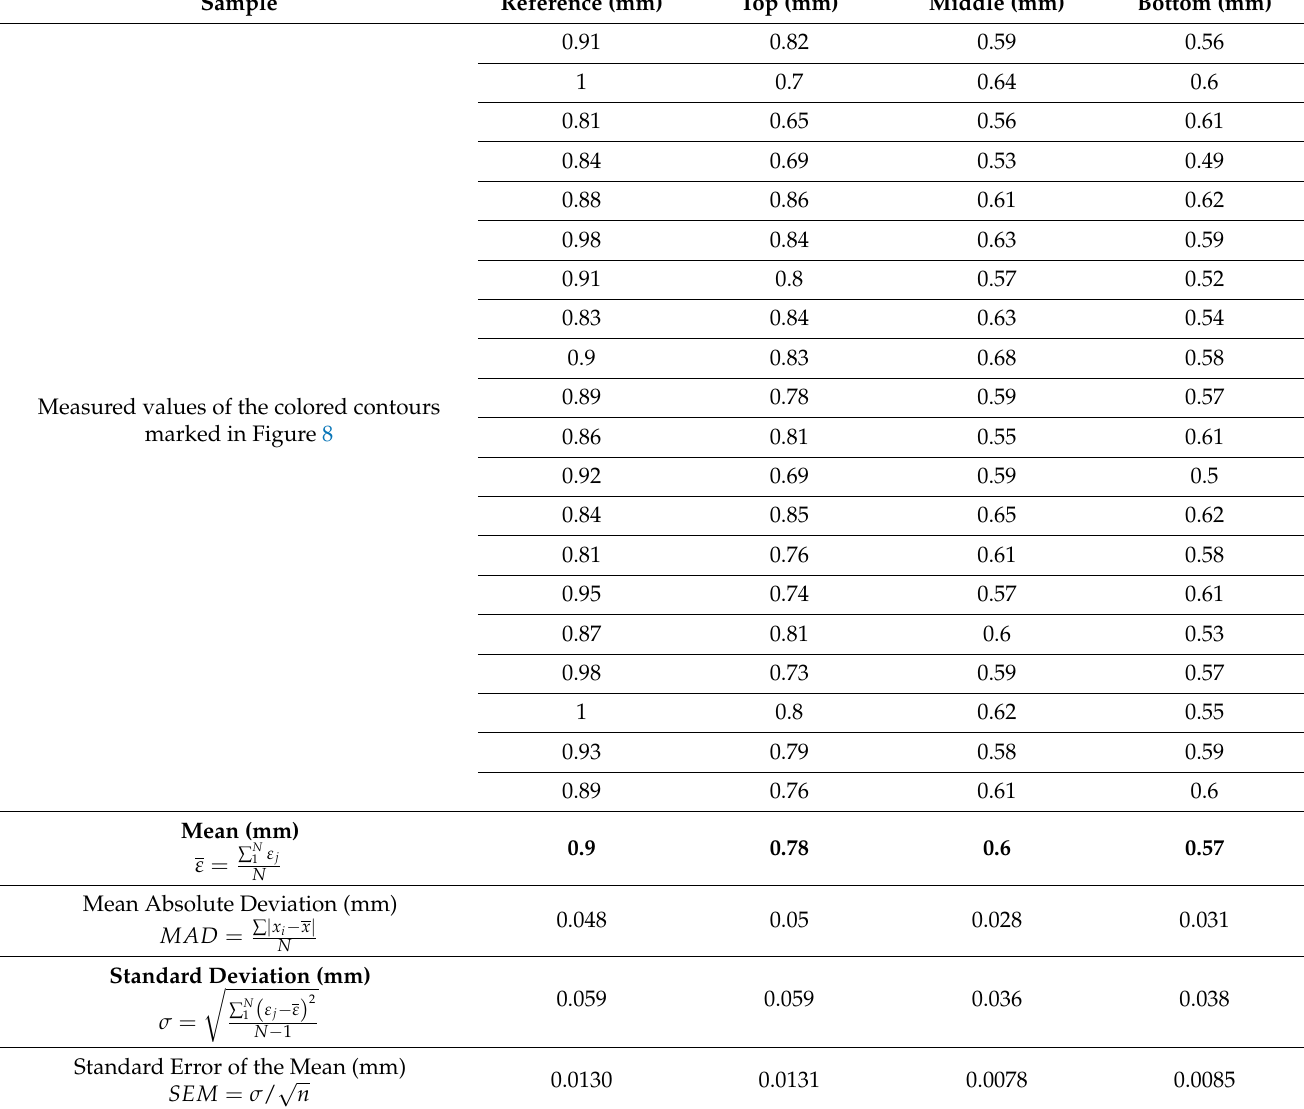
Table 1. Values of the lengths of the upper portions of the surface profiles of twenty B-scans, shown as examples marked with different colors in Figure 8, extracted from B-scans such as those shown in Figure 6. Evaluations using the program are shown on an example in Figure